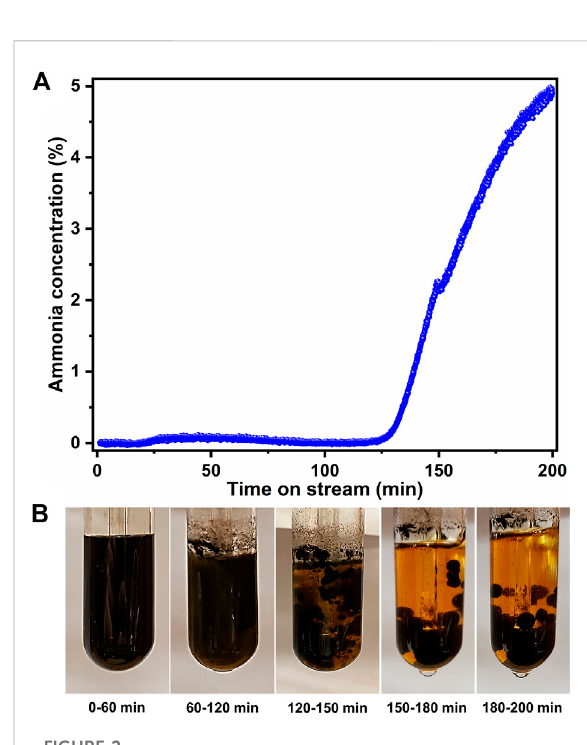
FIGURE 2 (A) ammonia concentration after bubbling through bio-oil as a function of time (B) digital photographs showing the separation trend of organic and aqueous